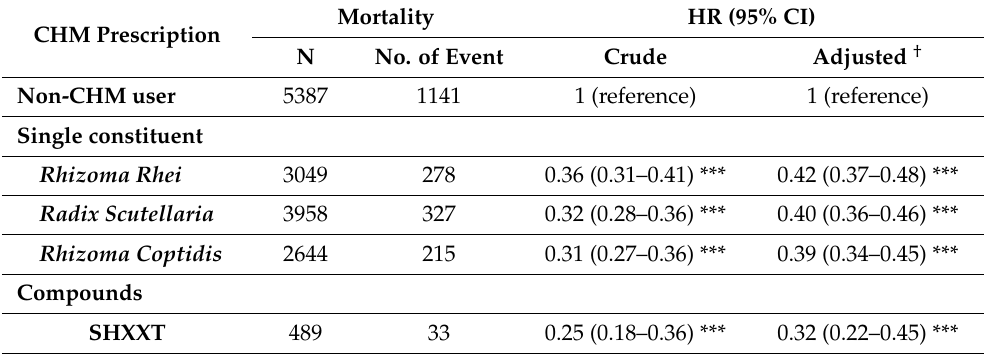
Table 6. The effects of CHM formulation on mortality rate among breast cancer